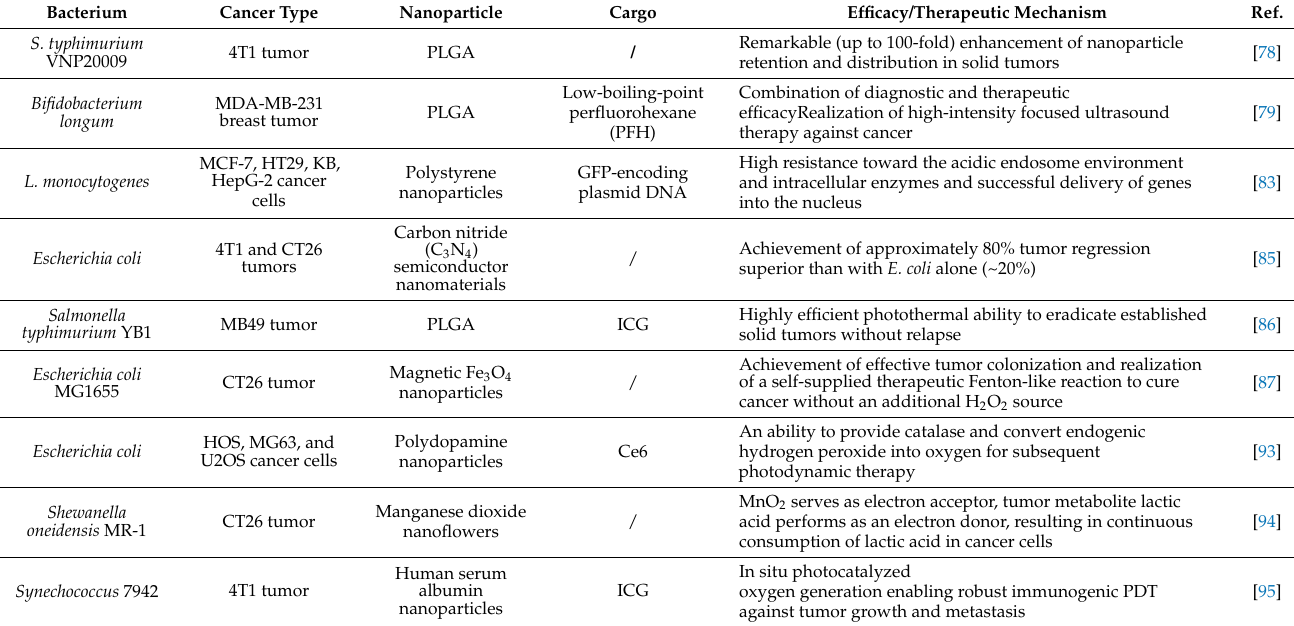
Table 3. Bacteria–nanoparticle hybrid systems in cancer